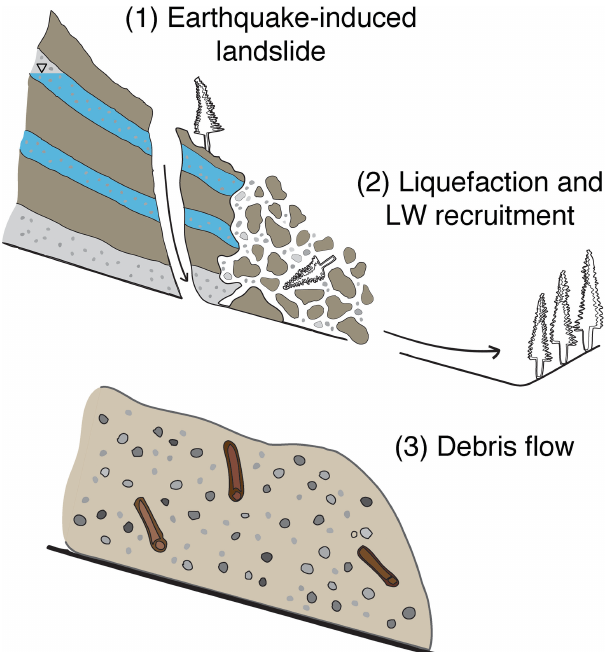
Figure 12. Conceptual model of transformation of earthquake- induced soil slips into debris flows at Popocatépetl Volcano: (1) the earthquake produces the collapse of the saturated slope composed of a mix of ash and pumice; (2) the landslide impacts on the op- posite side of the valley entraining a large amount of large wood (LW) and (3) evolves into a debris flow due to the high water con- tent of the material. The simplified stratigraphy in (1) reflects the one observed at the scarp of the Huitzilac landslide (see Fig.